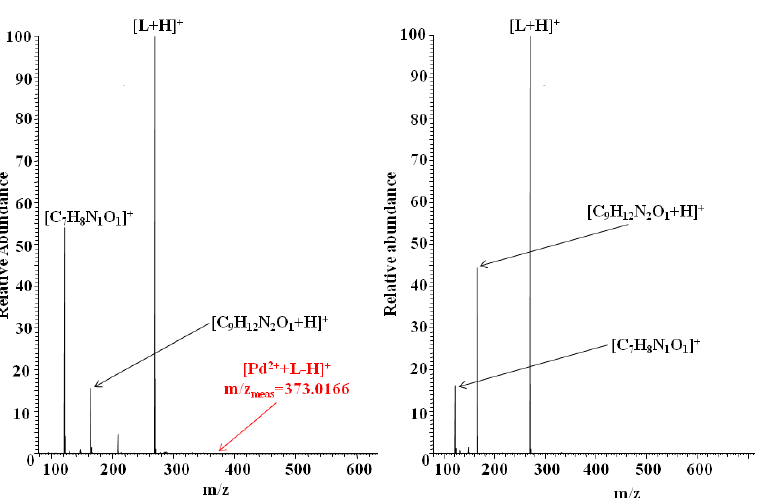
Figure 12. ESI-HRMS spectra recorded for the samples of the separated organic phases after liquid– liquid extraction containing N,N' -bis(salicylidene)ethylenediamine (L) and Pd 2+ ( left ) or Pt 2+ ( right ) ions, respectively. Unassigned minor signals correspond to ions not relevant to this study (e.g., formed by solvent molecules).